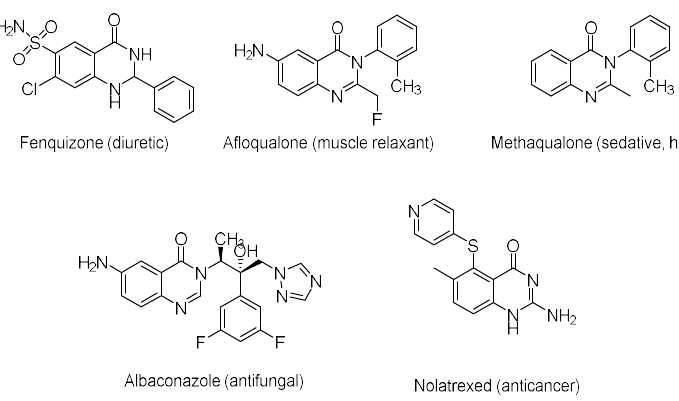
Figure 1. Representatives of 2,3-dihydroquinazolin-4(1 H )-one derivatives as therapeutic agents.